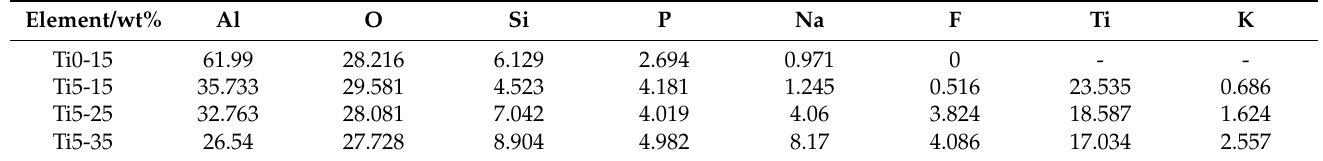
Table 2. EDS results of the surfaces of films Ti0-15, Ti5-15, Ti5-25 and